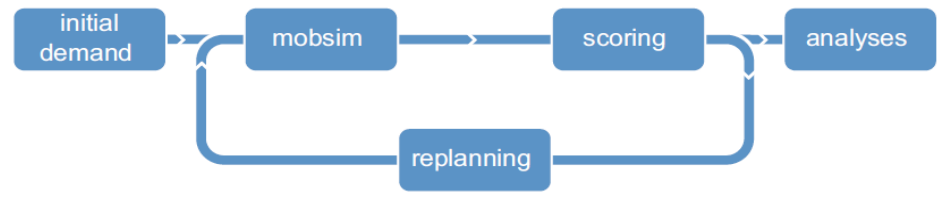
Figure 7. Evolution of the electric car fleet on the island of Tenerife between 2018 – 2040. On the one hand, the initial demand comes from the population’s daily activity